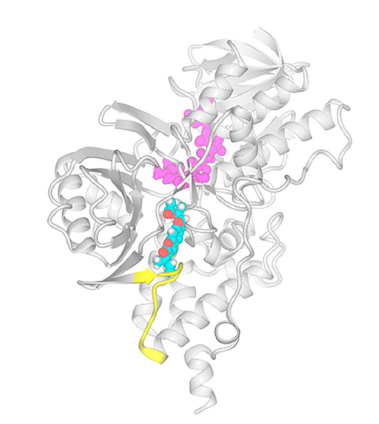
Figure 2. Monomer of h MAO-B molecule with lowest energy pose of ( S )-rutamarin molecule docked into the binding cavity. Ribbon diagram of overall protein structure in gray, the loop formed by residues 99–109, which admits ligands into the active site is highlighted in yellow. The FAD cofactor molecule is colored in magenta and while the ( R )-rutamarin is presented in ball mode with atom color coding mode: carbon—cyan, oxygen—red and hydrogen—white).